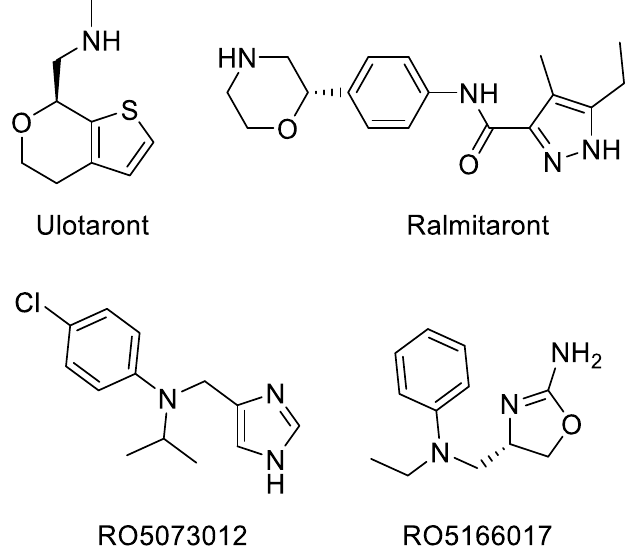
Figure 1. Advanced TAAR1 agonists at various stages of investigation: Ulotaront (phase III clinical trials), Ralmitaront (phase II clinical trials), RO5073012 (preclinical investigation) and RO5166017 (preclinical investigation).